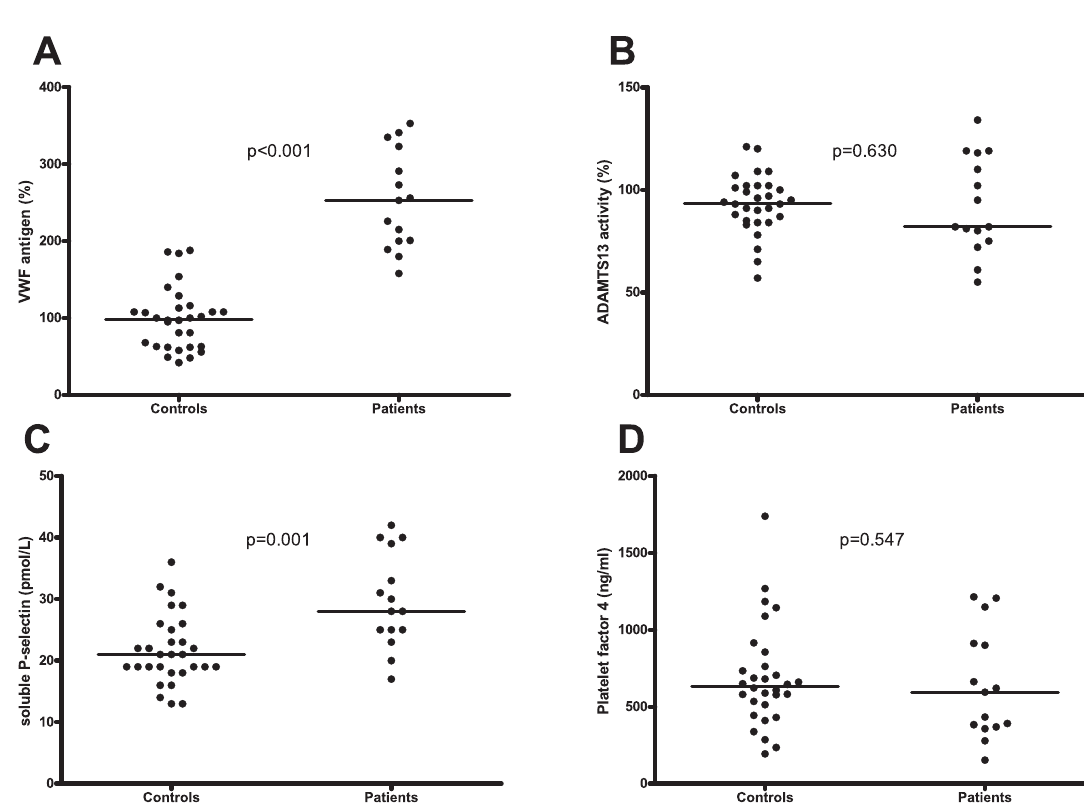
Figure 1. VWF and Platelet parameters in healthy controls and patients. A . Plasma levels of von Willebrand factor (VWF) in patients and healthy controls. B . ADAMTS13 activity in plasma from patients and healthy controls. C . Plasma levels of soluble P-selectin in patients and controls. D . Plasma levels of Platelet Factor 4 in patients and controls. Horizontal bars indicate medians.